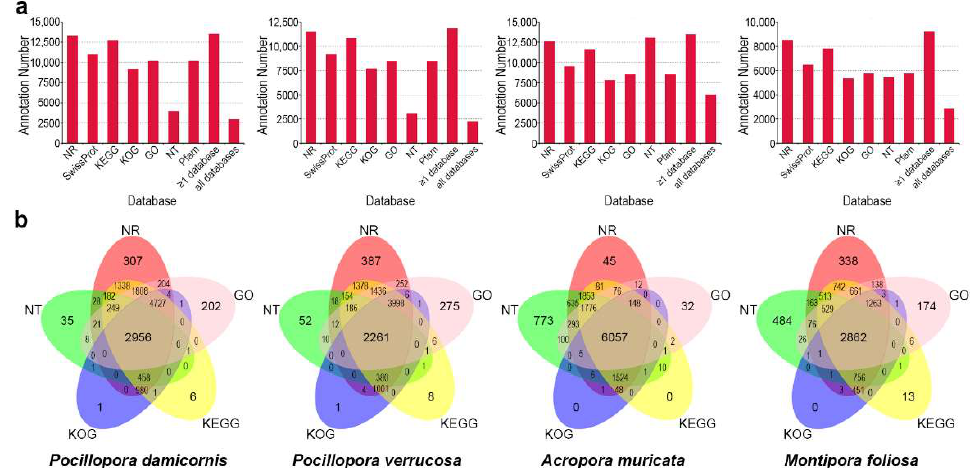
Figure 1. Summary of coral gene-function annotation. ( a ) Statistics of the annotation results of four reef-building corals, excluding Symbiodiniaceae sequences, in the NR, Swiss-Prot, KEGG, KOG, GO NT, and Pfam databases. The horizontal axis represents the different functional databases, and the vertical axis represents the number of sequences annotated in different functional databases, at least one database, and all databases. ( b ) Venn plots of the number of annotated sequences of four reef-building corals excluding Symbiodiniaceae sequences obtained using the NR, KEGG, KOG, GO, and NT databases. The sum of the numbers in each large circle represents the number of transcripts annotated in one database, and the overlapping circles indicate the numbers of transcripts annotated in these databases